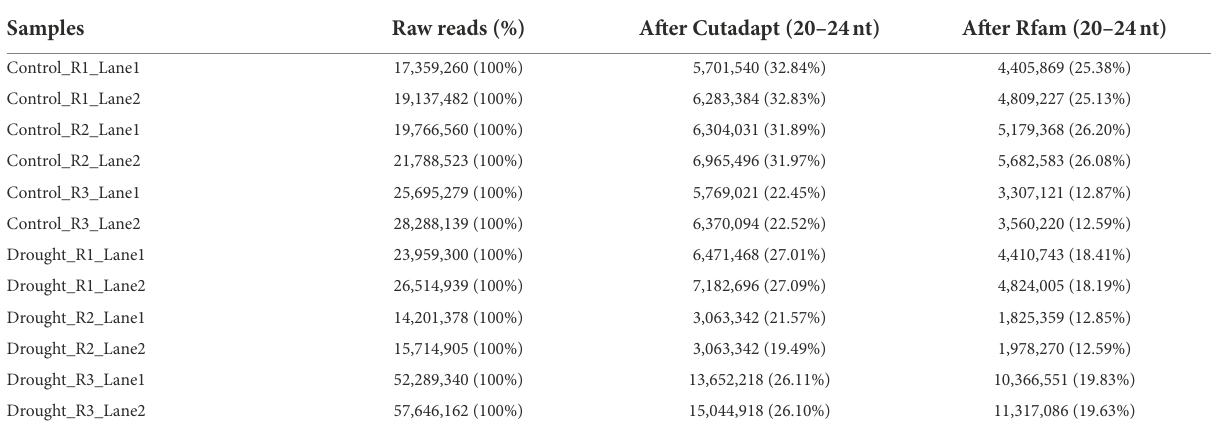
TABLE 1 Oil palm sRNA statistics and clean read length distribution.